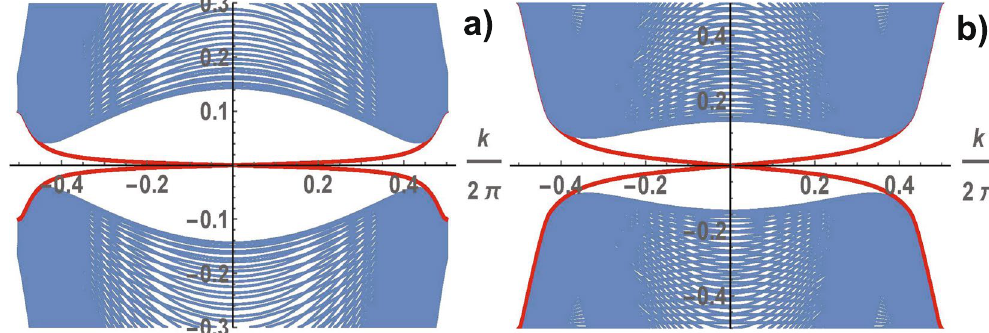
Figure 5. Detail of the band structure for a system in the stripe geometry with the same parameters as in Fig. 3; the TSC gapped state with φ = π at μ = 0.1, Δ = 0.1 ( a ), μ = 0.5, Δ = 0.1 ( b ). Only the low energy excitations 2 are shown, although all four bands were considered in the